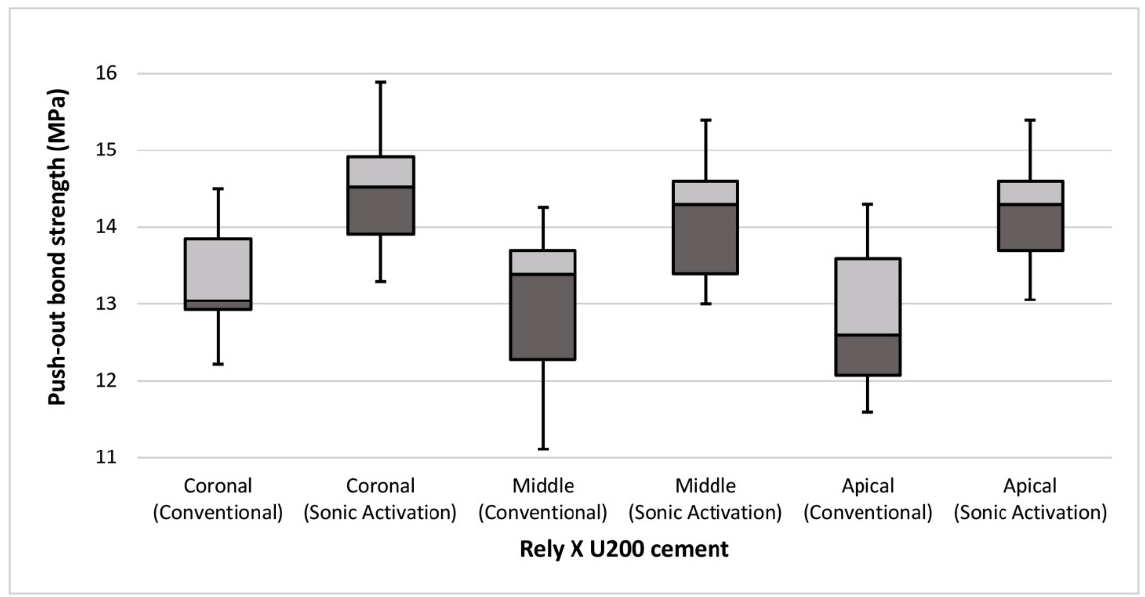
Figure 3. Comparison of mean bond strength between conventional and sonic activation at different root levels in Rely X U200 SARC.